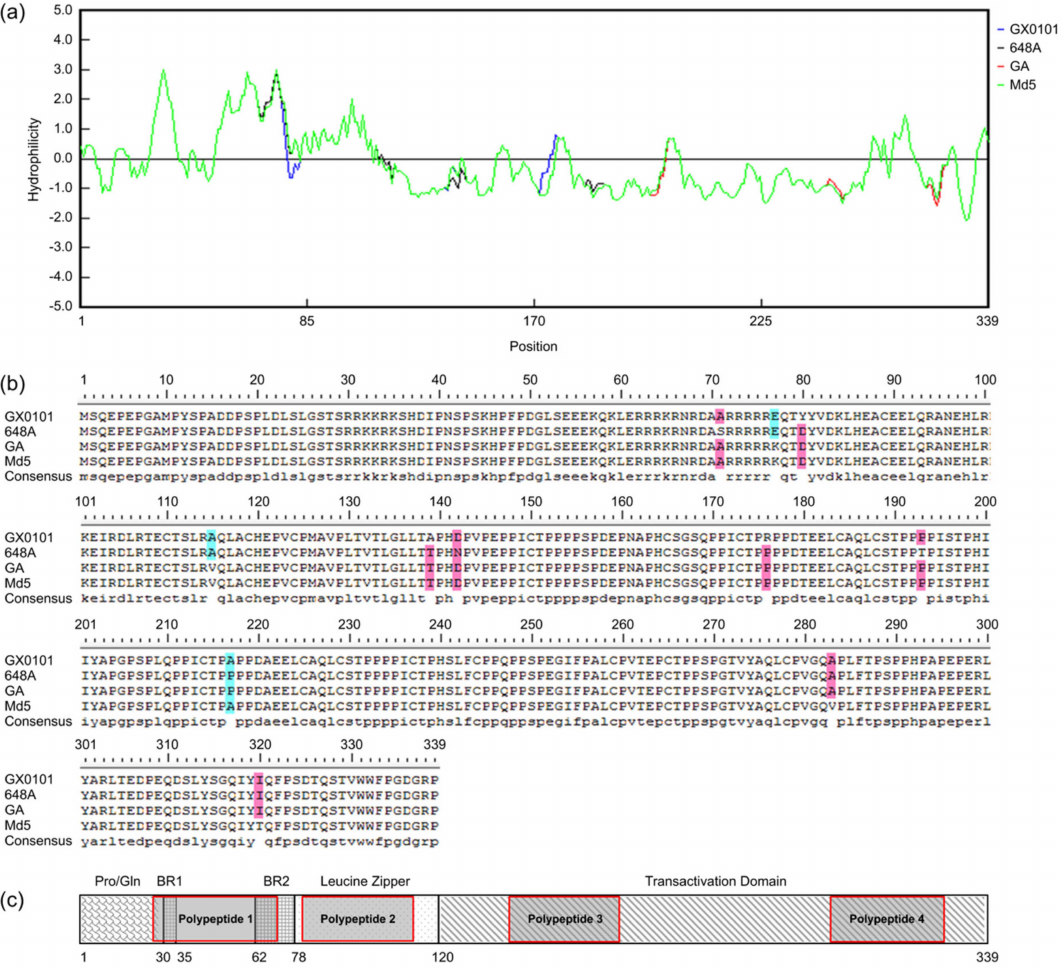
Figure 1. Amino acid sequence alignment, hydrophilicity and molecular structure analysis of the Meq proteins. ( a ) Comparison of amino acid hydrophilicities of different virulence MDV − 1 Meq proteins. The upper half of the baseline represents the hydrophilic regions. The green curve represents the Md5 strain used as reference. The blue, black and red curves represent the amino acid difference region of GX0101, 648A and GA strains relative to Md5 strain, respectively. ( b ) Amino acids point mutation analysis of the Meq proteins of four MDV − 1 strains with different virulence. Blue and pink indicate the mutant amino acids of different strains. ( c ) The genomic location and domain diagram of MDV − 1 Meq protein. The relative positions of synthetic polypeptides are shown by shaded grey boxes with red